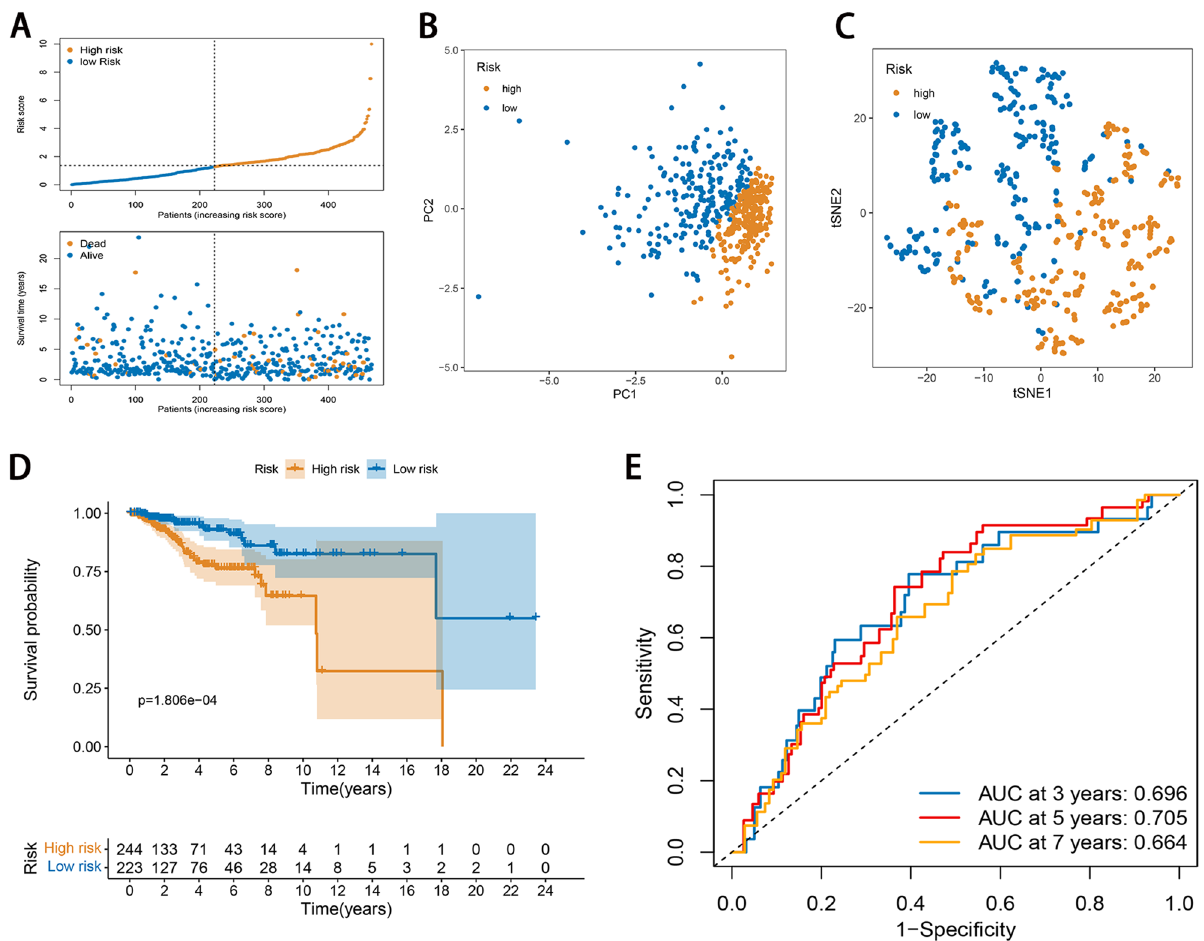
Figure 3. Evaluation of the signature in the testing set. ( A ) The distribution and value of the risk scores. ( B ) PCA of breast cancer patients according to the risk score. ( C ) t-SNE of breast cancer patients according to the risk score. ( D ) Kaplan–Meier curves for OS in high- and low-risk groups. ( E ) ROC curve analysis shows the predictive efficiency of the established risk